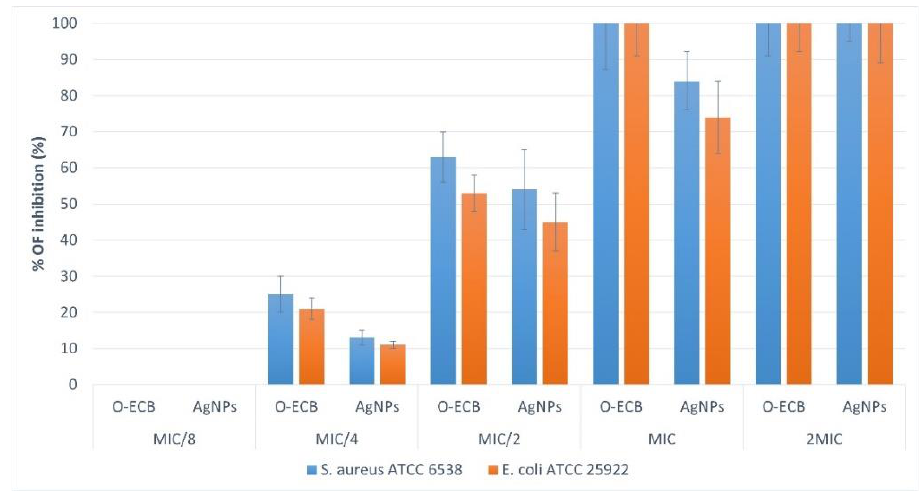
Figure 8. Antibiofilm activity of optimized ethanolic extract of E. chlorantha bark (O-ECB) and green-synthetized silver nanoparticles (AgNPs).